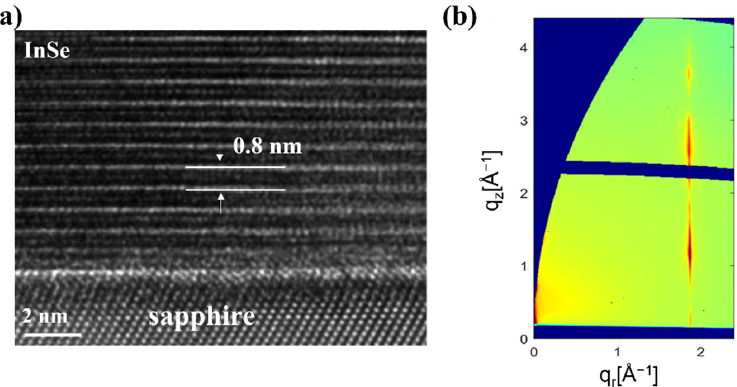
Figure 4. ( a ) Cross-sectional HR-TEM image and ( b ) 2D GIWAXS profile of γ -InSe films with high In/Se ratio at 50 min deposition time.